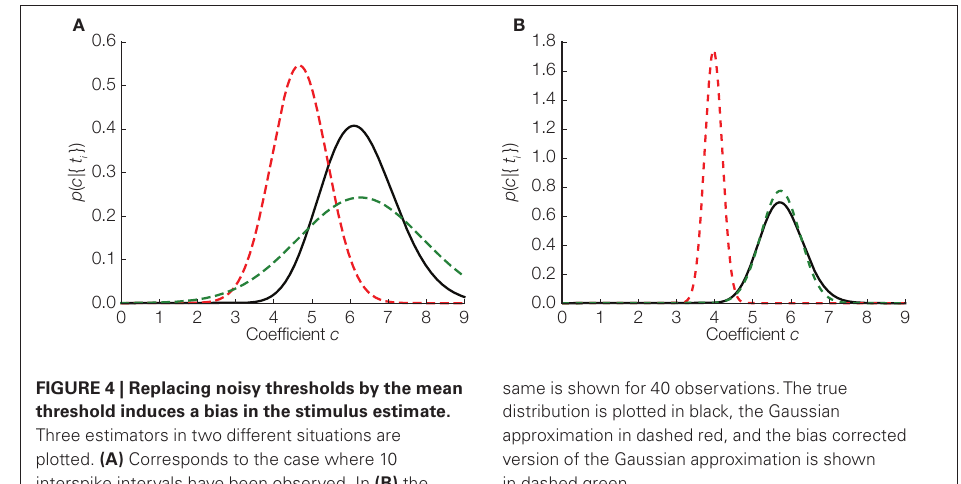
Figure 4 | replacing noisy thresholds by the mean threshold induces a bias in the stimulus estimate. Three estimators in two different situations are plotted. (A) Corresponds to the case where 10 interspike intervals have been observed. In (B) the